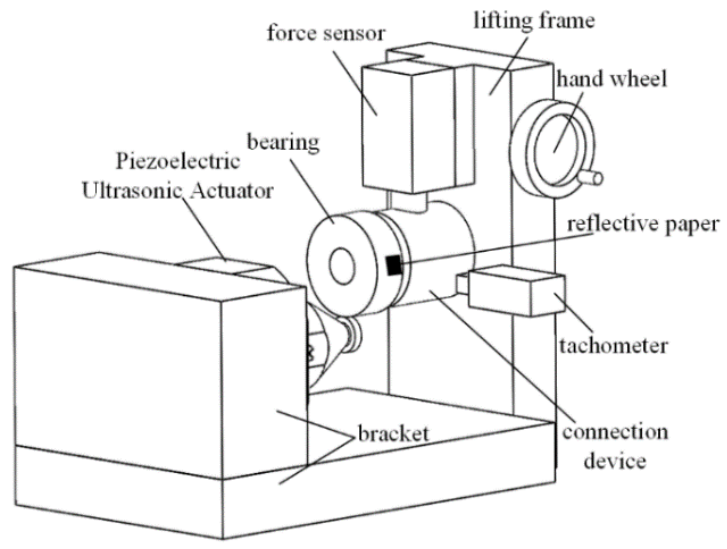
Figure 2. Friction pair test experimental device.